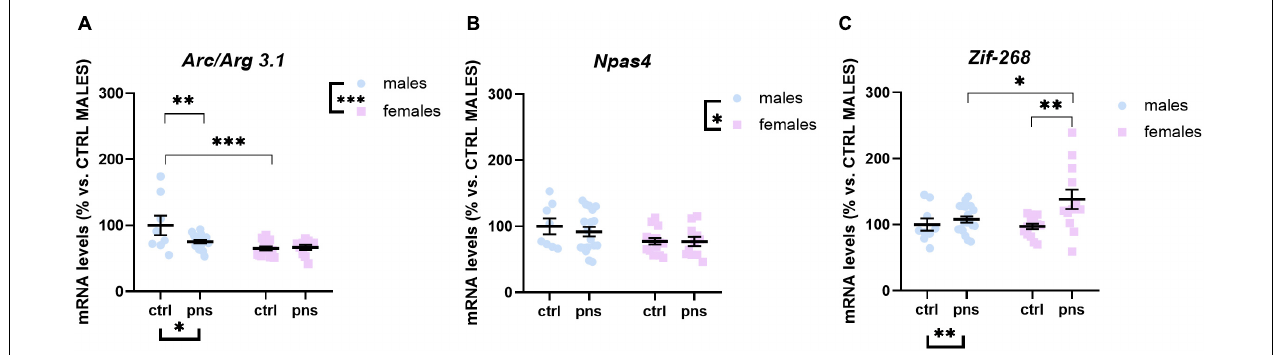
FIGURE 7 | Analysis of ( A ) Arc/Arg 3.1 , ( B ) Npas4 , and ( C ) Zif268 mRNA levels in the amygdala of males and females exposed to prenatal stress. Data are expressed as a percentage of control males not exposed to stress (set at 100%) and represent the mean ± SEM of at least 10 independent determinations. Data information: symbols represent individual data. ∗ p < 0.05; ∗∗ p < 0.01; ∗∗∗ p < 0.001 vs. control males (two-way ANOVA with Bonferroni’s multiple-comparison